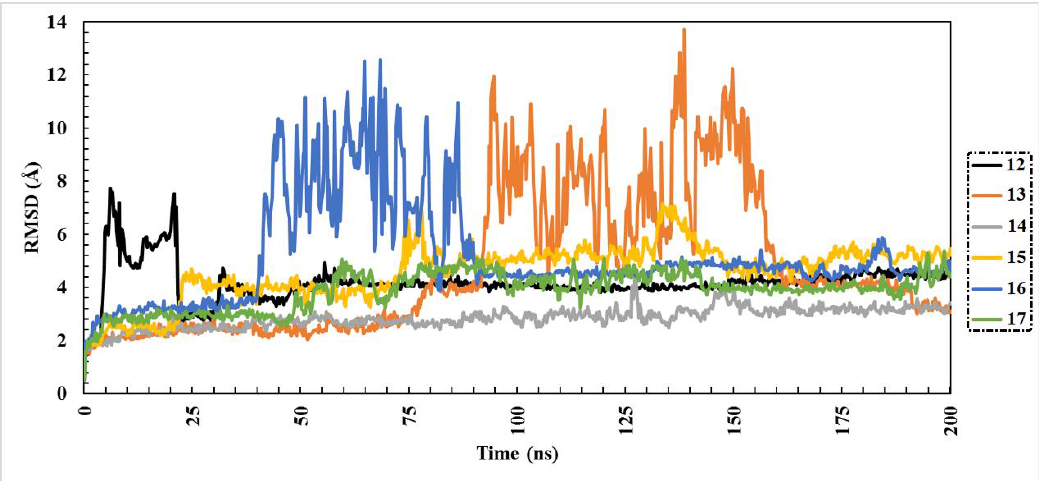
Figure 3. Root-mean-square deviation (RMSD) of Omicron backbone atoms from the initial structure complexed with the highest-ranked drugs over 200 ns MD simulations.